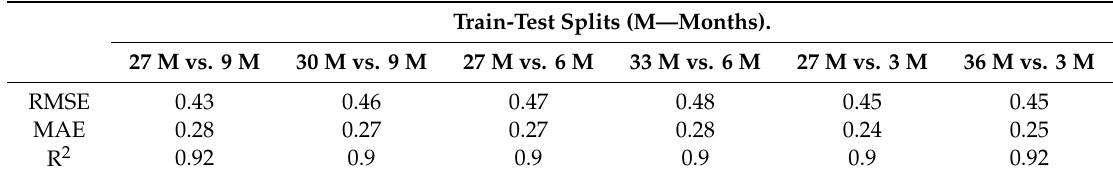
Table 6. Performance of models with di ff erent train-test splits. Train-Test Splits (M—Months).